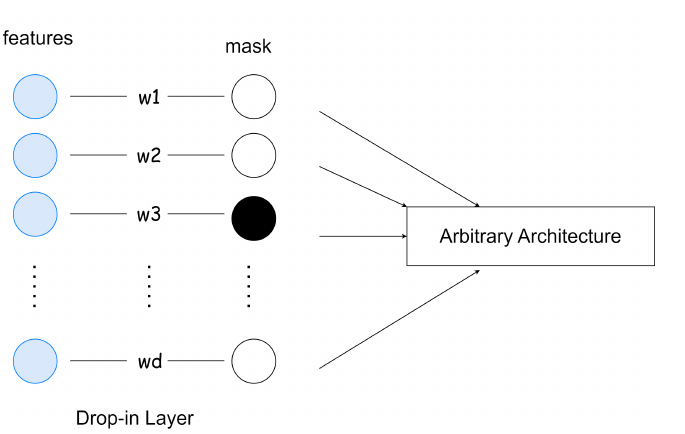
Figure 4. Modified network with our drop-in layer